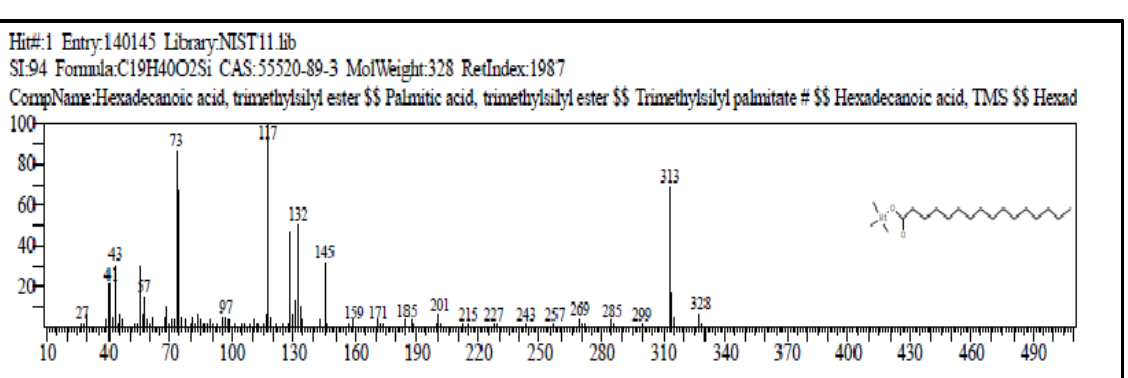
Figure20. ( A1) Mass spec. of peak 1